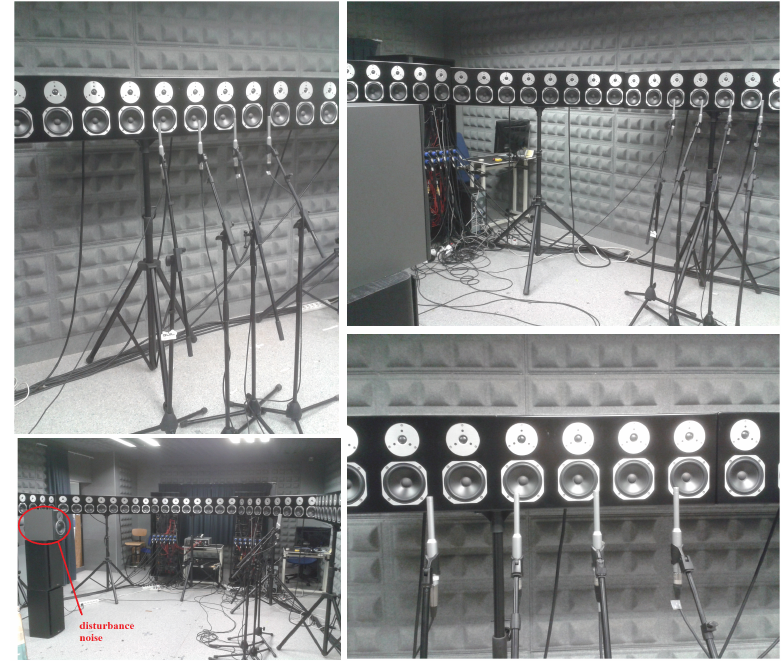
Figure 7. Photograph of the ANC prototype in the listening room at the Audio Processing Laboratory of the Polytechnic University of